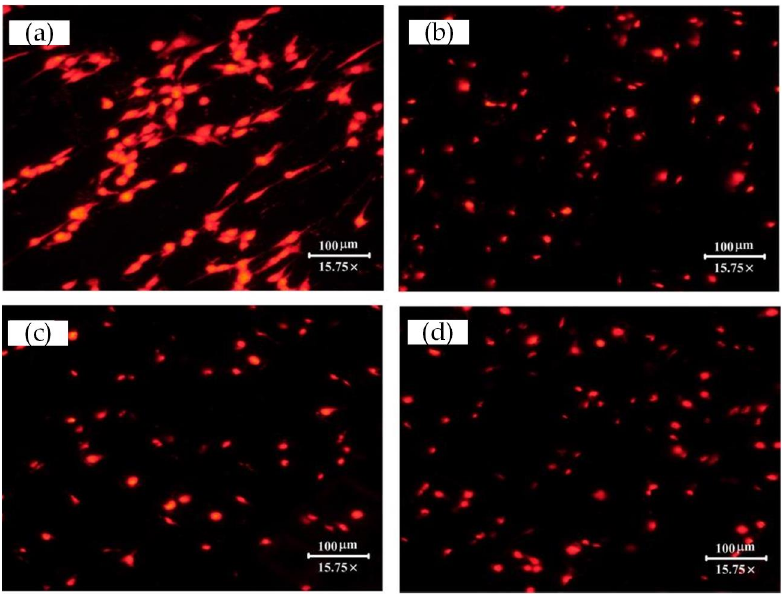
Figure 9. Stereo fluorescence microscope pictures taken for MC3T3-E1 cells adherent on the different surfaces after culturing for 22 h presented the variation in cell density and cell numbers: ( a ) Smooth; ( b ) Texture 1; ( c ) Texture 2; and ( d ) Texture 3.